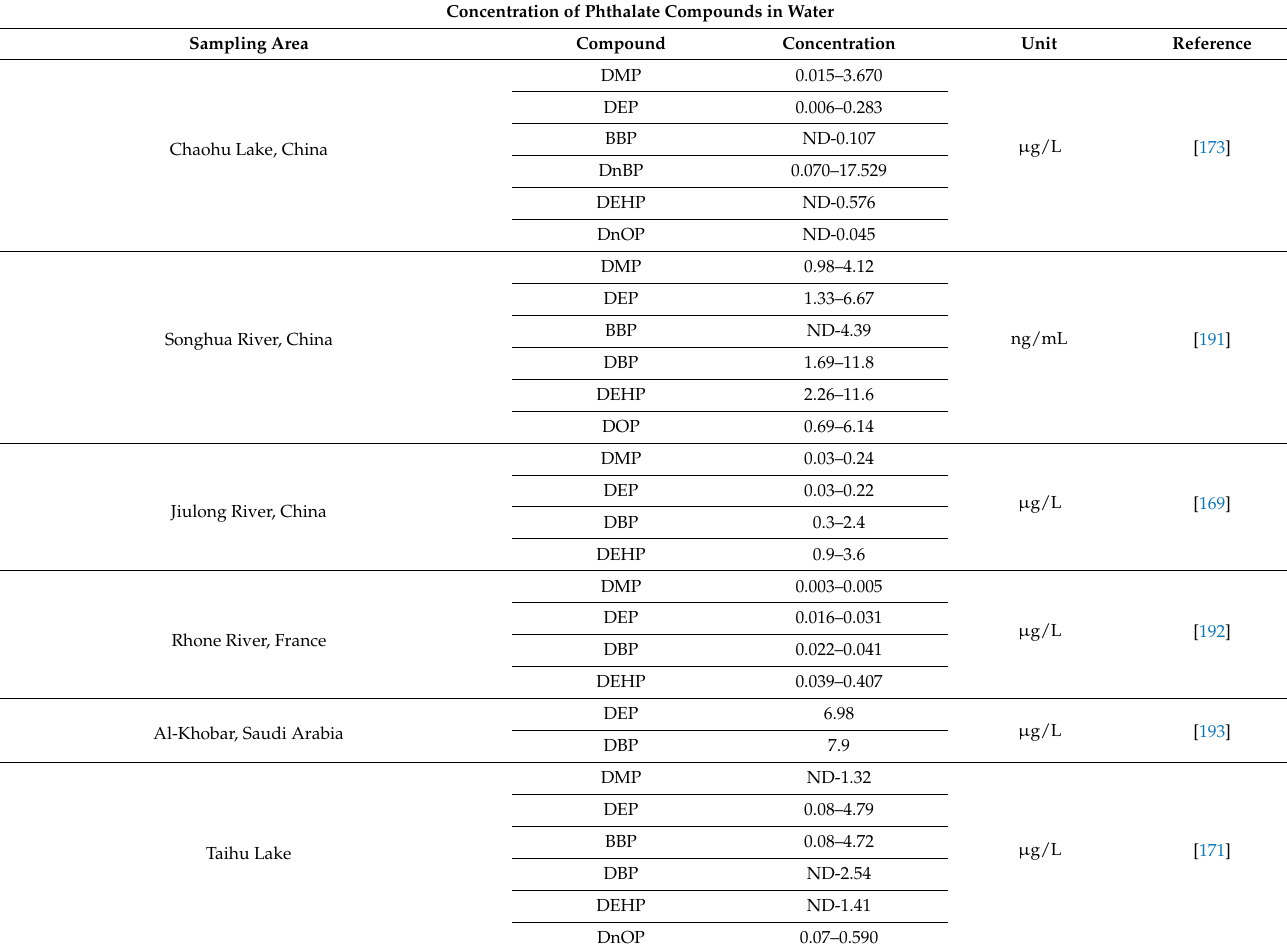
Table 3. Phthalates in environmental matrices and human